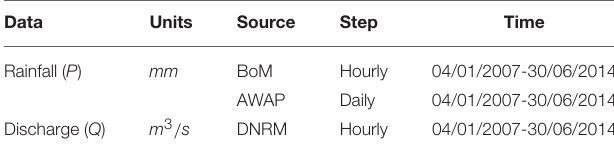
TABLE 1 | Data source.